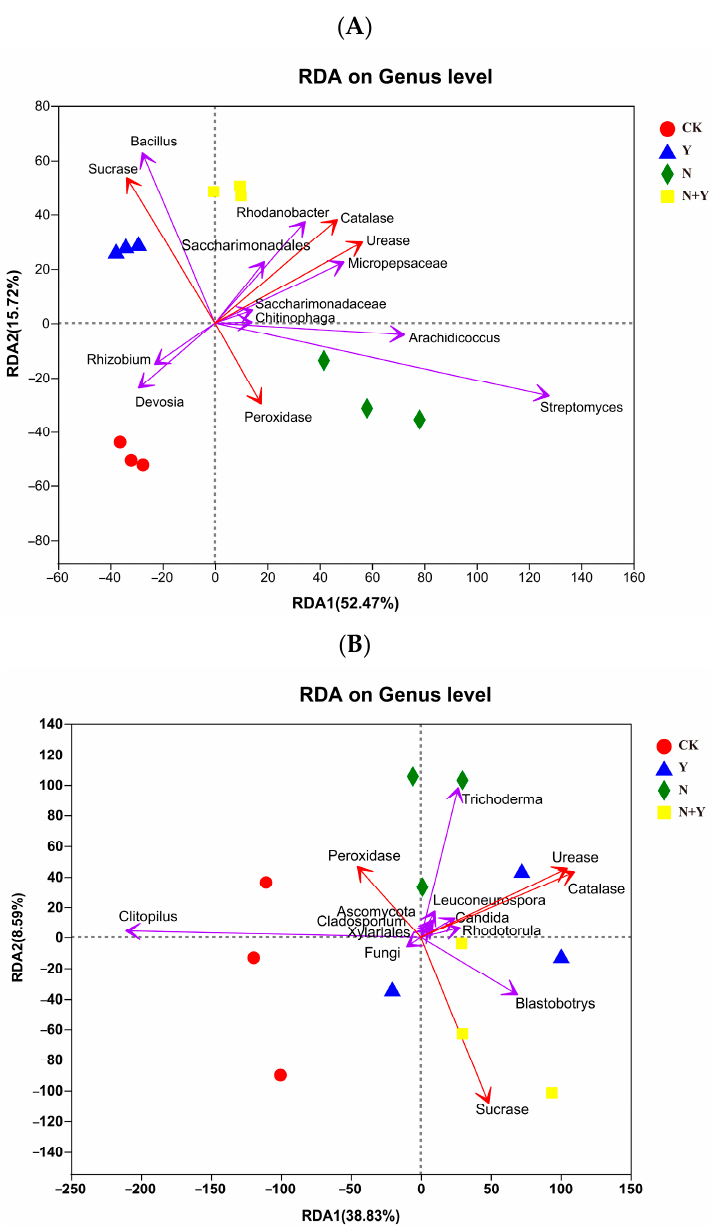
Figure 7. Redundancy analysis (RDA) based on the OTUs of the top 10 bacterial ( A ) and fungal ( B ) genera and selected environmental variables for samples collected from different treatments. Different treatments: CK (control), seedlings were irrigated with normal nutrient solution; Y, control + B. subtilis K424; N, four-strength control; N + Y, four-strength control+ B. subtilis K424.